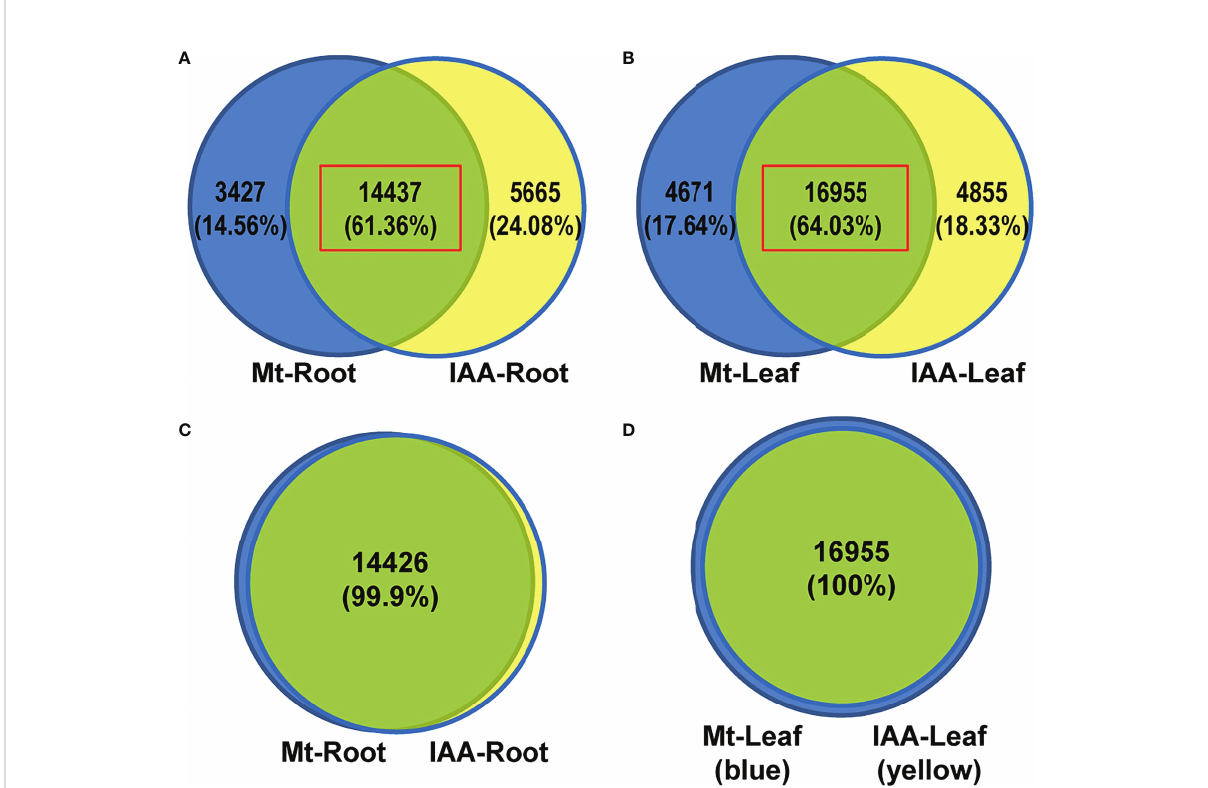
FIGURE 1 DEG analysis of Melatonin (Mt) or IAA treated transcriptome data. (A) Venn diagram of DEGs in roots. (B) Venn diagram of DEGs in leaves. (C) A venn diagram results from the time series analysis in roots. The 14437 common genes of melatonin- and auxin-treated roots, red box in (A) , were analyzed using a time series assay and only 11 of them were not clustered. (D) A venn diagram results from the time series analysis in leaves. The 16955 common genes of melatonin- and auxin-treated leaves, red box in (B) , were analyzed using a time series assay and all of them are able to be